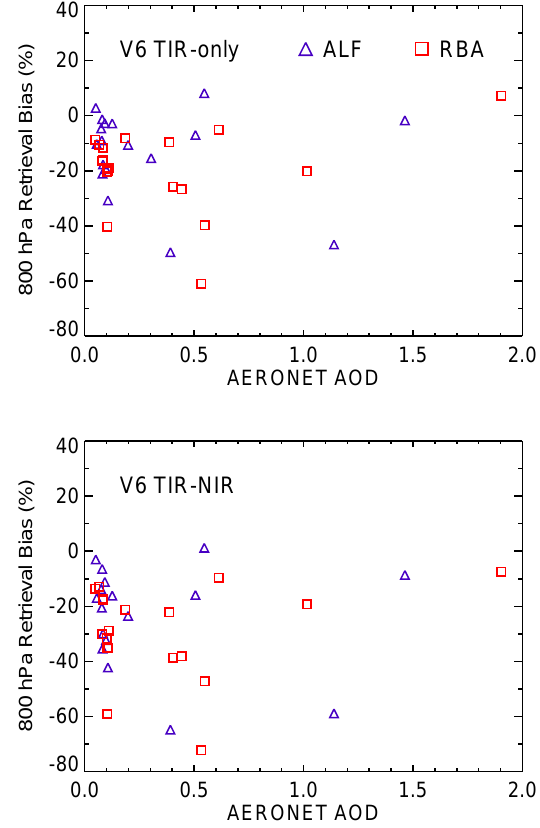
Figure 8. Comparison of observed MOPITT TIR-only and TIR- NIR retrieval biases at 800hPa at two Amazonian sites with ground- based measurements of aerosol optical depth at 500nm from the AERONET network. Each plotted point indicates the mean MO- PITT retrieval bias and daily-mean AOD for a single daytime MO- PITT overpass of one of the two AERONET sites. While there are relatively few data points at high AOD values, the plotted data do not indicate a clear AOD dependence for the retrieval bias for either type of MOPITT